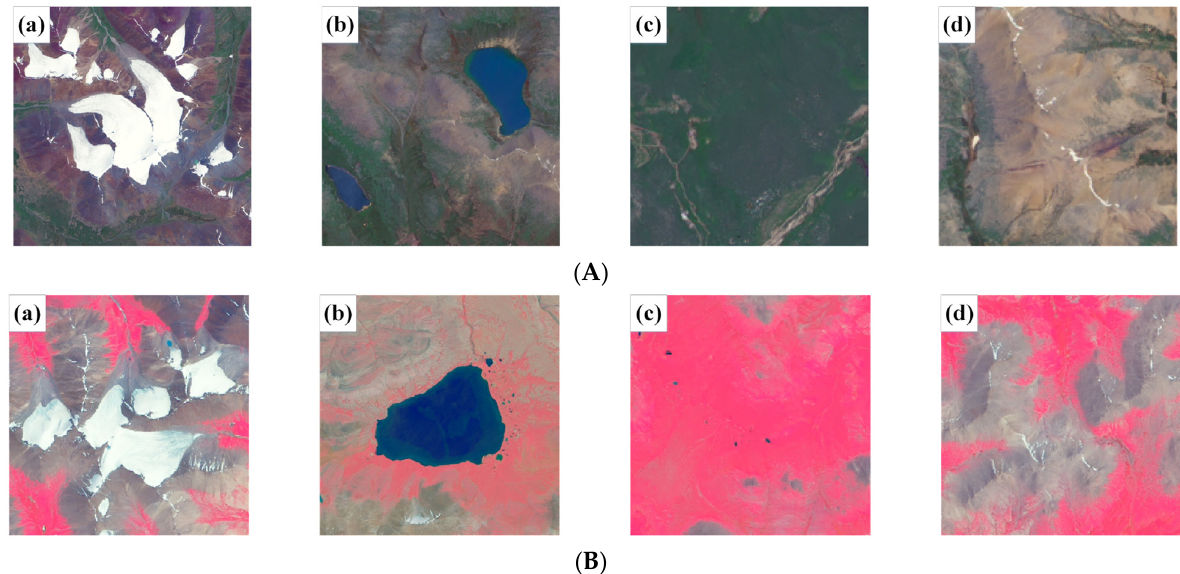
Figure 6. The interpretation signs of eco-environment elements. ( a ) Glacier; ( b ) water; ( c ) grassland; ( d ) bare land. ( A ) is the true-color image and ( B ) is the false-color image.